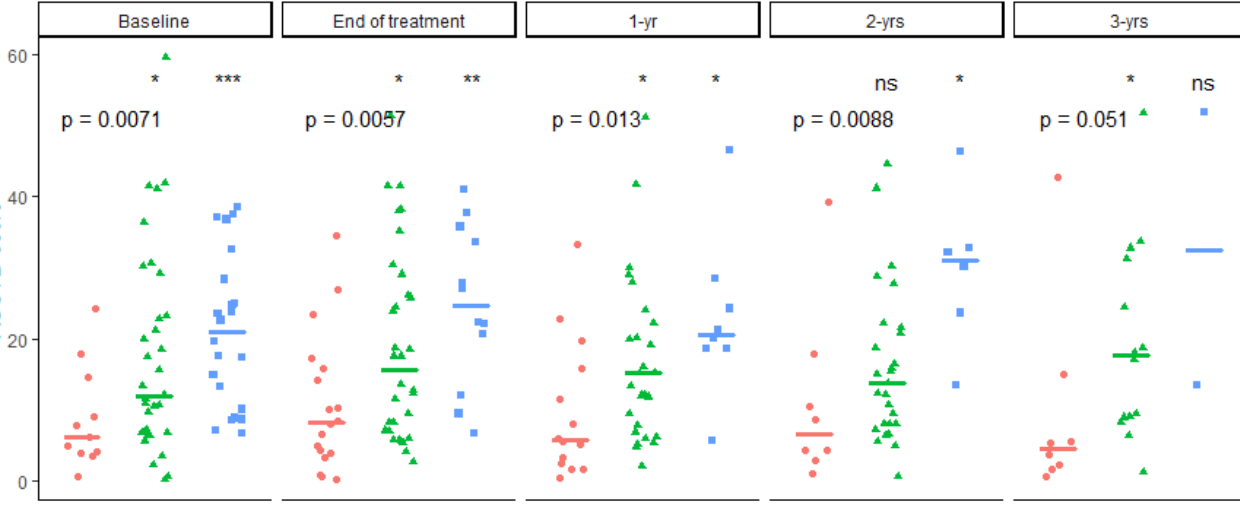
Figure 3. ASCVD score variation according to FIB-4 score groups and time. ASCVD, Atherosclerotic Cardiovascular Disease 2013; FIB-4, fibrosis-4 index. ns: non-significant p-value (>0.05). *: (0.01, 0.05), **: (0.001, 0.01], ***: [0, 0.001], determined by Wilcoxon rank sum test (taking no fibrosis as Overall p-values calculated using Kruskal-Wallis rank sum test